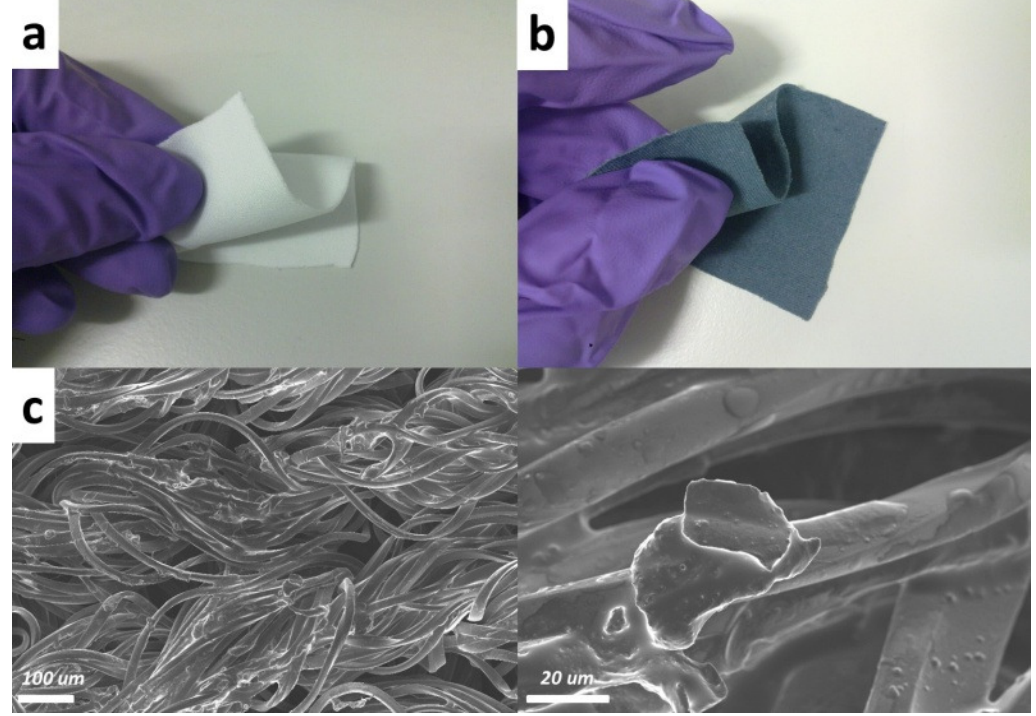
Figure 1. Picture of ( a ) polyester/cellulose fabric; ( b ) poly(3,4-ethylenedioxythiophene) (PEDOT) soaked polyester/cellulose fabric as textile battery electrodes and ( c ) scanning electron microscope (SEM) images of the soaked